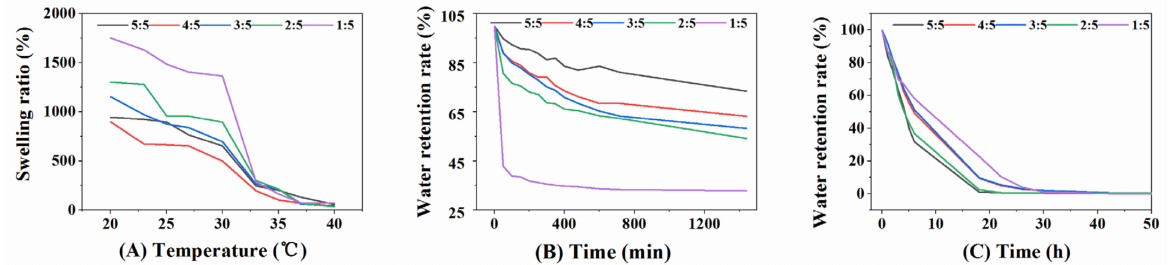
Figure 1. ( A ) Swelling ratios of the PNIPAAm-BIS-Clay hydrogels as a function of temperature, ( B ) Deswelling kinetics of the PNIPAAm-BIS-Clay hydrogels at 45 ◦ C, ( C ) water retention of the PNIPAAm-BIS-Clay hydrogels.